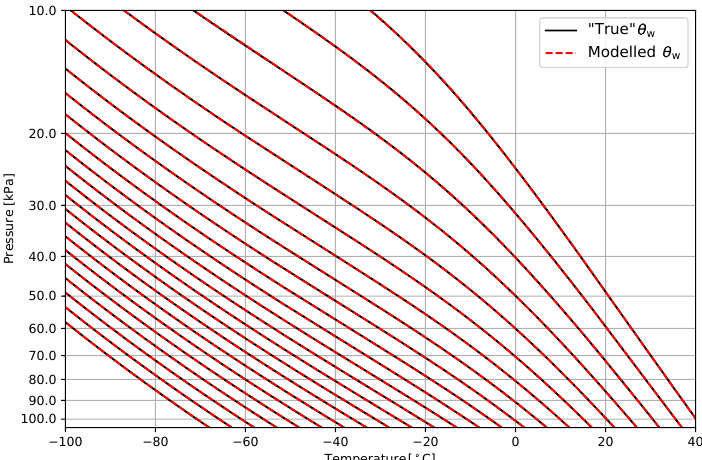
Figure 1. Emagram plot showing select “true” (solid black) and modelled (dashed red) moist adiabats θ w (difference not apparent at this scale). Temperature and pressure domains are restricted for clarity. An emagram (energy mass diagram) is a thermodynamic diagram with the log of pressure on the vertical axis, plotted with maximum and minimum values reversed so that higher in the diagram corresponds to higher in the atmosphere, where pressures are lower. The noniterative results presented in this paper can be plotted on any thermodynamic diagram, including tephigrams and skew-T